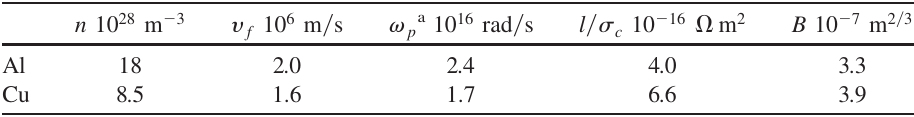
TABLE I. Free-electron Fermi gas model parameters for Al and Cu [17] and constants l=(cid:3) c and B calculated from Eqs. (9) and (10)